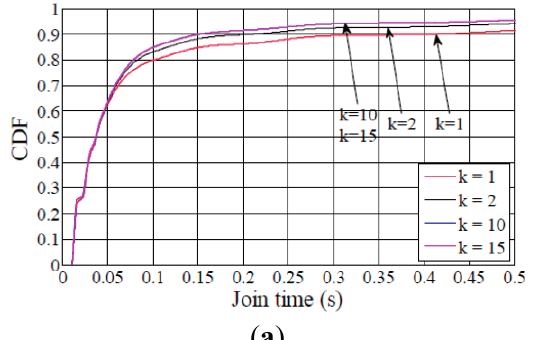
Figure 8. CDF of nodes join time for an average node degree of 5: ( a ) small, ( b ) medium, and ( c ) large network size